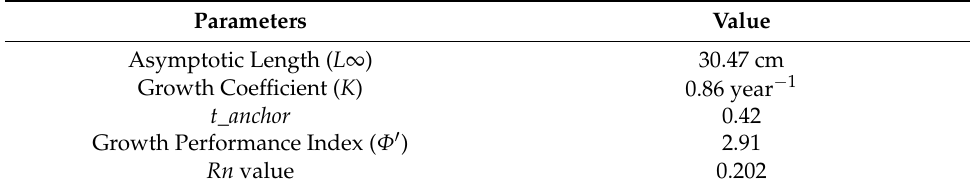
Table 2. Growth parameters of Bombay duck.